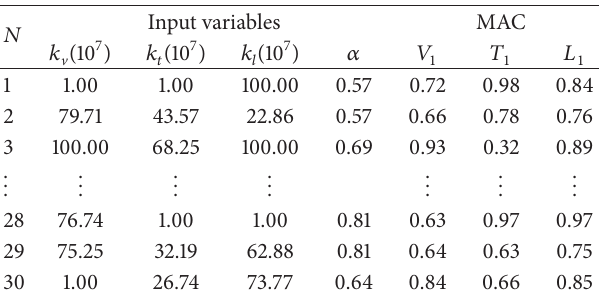
Table 2: Experimental samples. Table 3: 𝑅 2 and RMSE values.